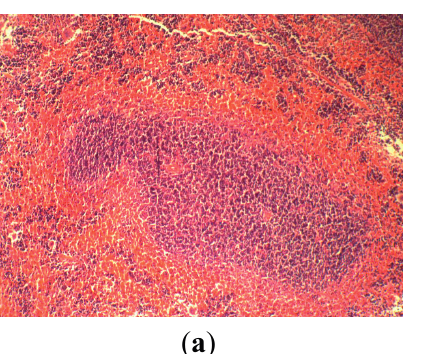
Figure 6. Spleen tissues on 72 h post-infection with C. albicans , ( a ) uninfected spleen; H&E stain; original magnification, ×400 (There is no architecture loss, necrosis or polymorphonuclear infiltration in the spleen tissue) ( b ) H&E stain; original magnification, ×40 (Spleen tissue appear normal with no evidence of tissue pathology); ( c ) PAS stain; original magnification, ×400 (Arrows indicated few hyphae and fungal bodies of C. albicans observed); ( d ) PAS stain; original magnification, ×400 (Arrows indicate few hyphae and fungal bodies of C. albicans